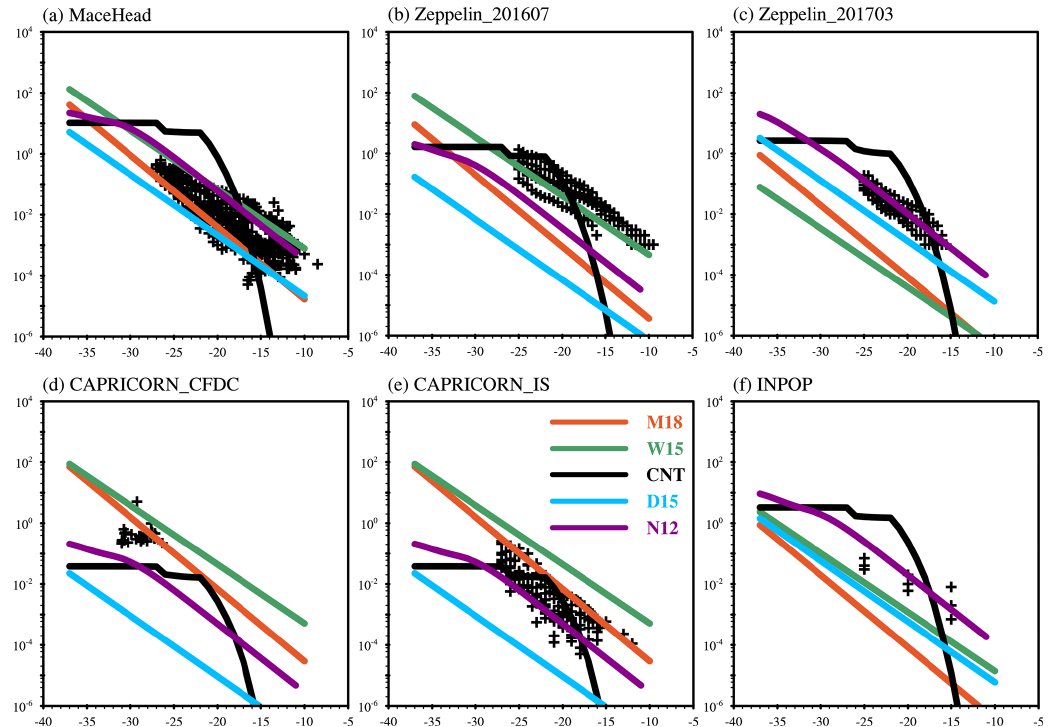
Figure 5. Modeled and observed INP concentrations as a function of temperature. The black crosses indicate INP measurements, and lines show model results from different parameterizations (Table 4). Simulated INP data are sampled at the same pressures, longitudes, and latitudes as the field